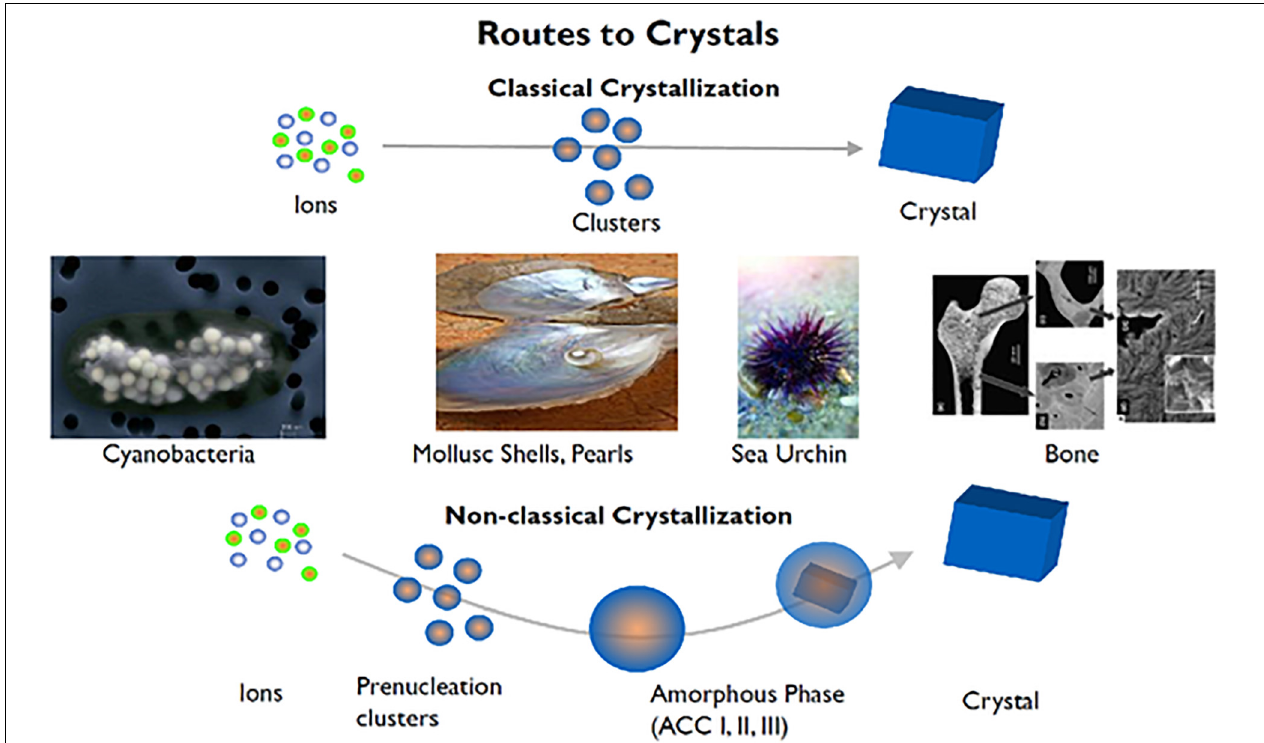
FIGURE 1 | Biological crystallization of diverse mineralized tissues ranging from sea urchin spines to bones and teeth demonstrate a non-classical crystallization pathway. From calcium carbonate (CaCO 3 ) to hydroxyapatite (Ca 10 (PO 4 ) 6 (OH)), these divergent mineralization systems have been found to contain intermediates mineral phases not explained by classical crystallization theories. Adapted from Coelfen and Antonietti (2008) with permission from John Wiley and